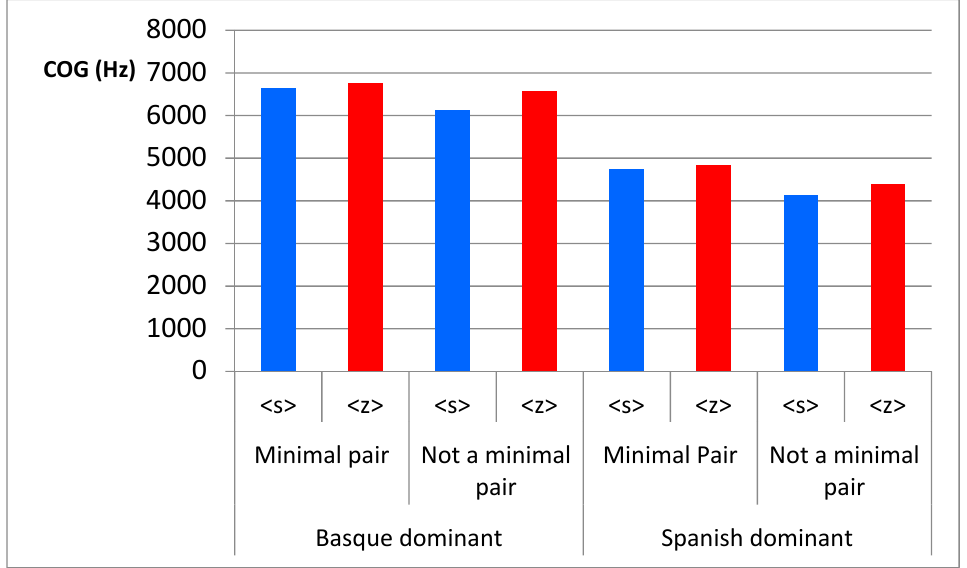
Figure 5. Graph for the letter, language dominance, status of the word as having a minimal pair or not and mean COG values.